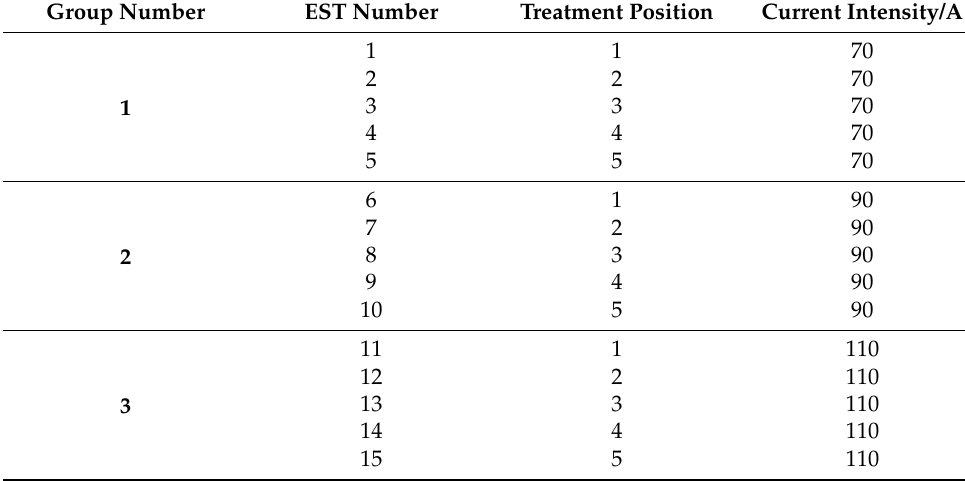
Table 3. EST processing parameters.